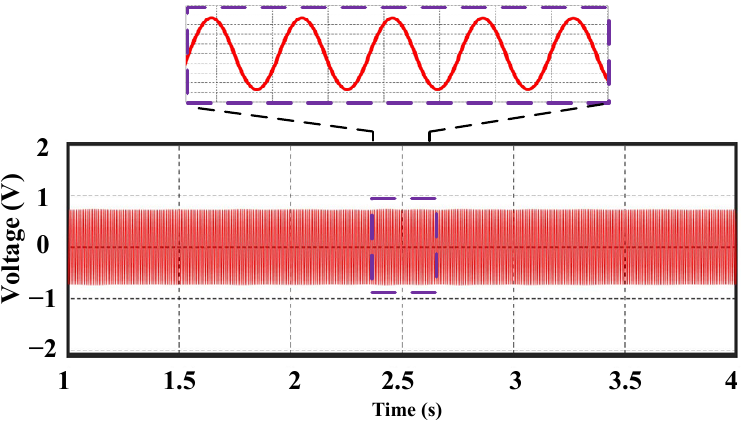
Figure 6. Injected Figure 6. Injected signal.